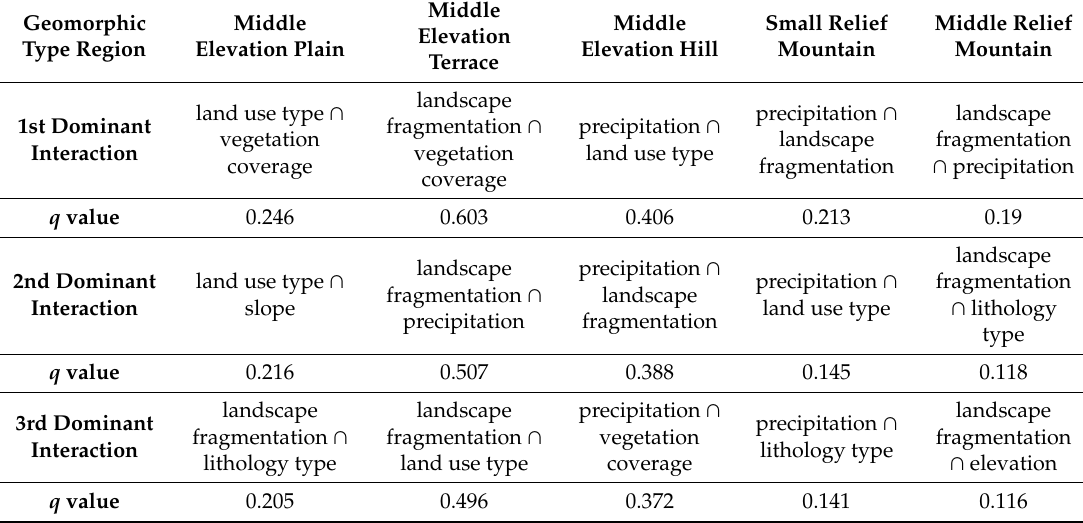
Table 5. The e ff ects of the dominant interactions of two covariates on the surface runo ff of the di ff erent geomorphic